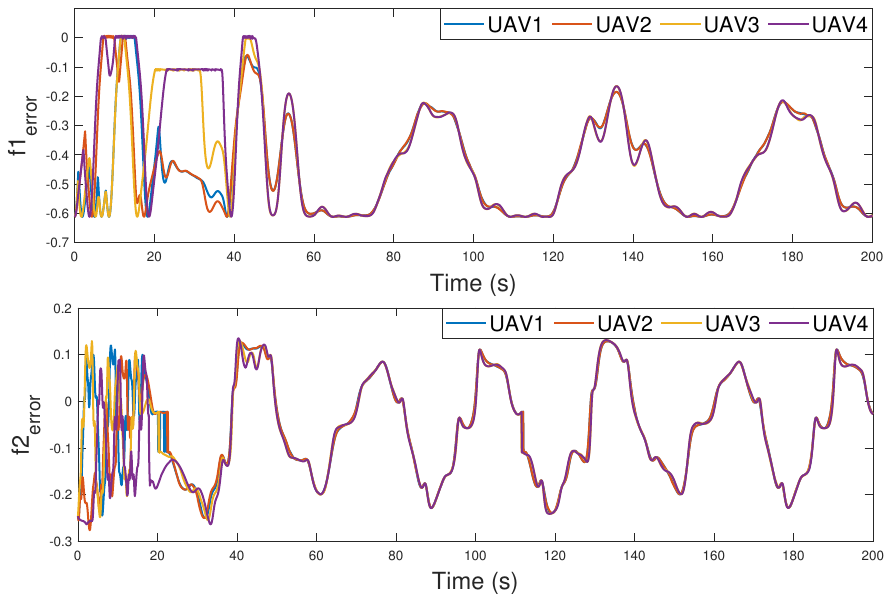
Figure 4. Estimation error of GP